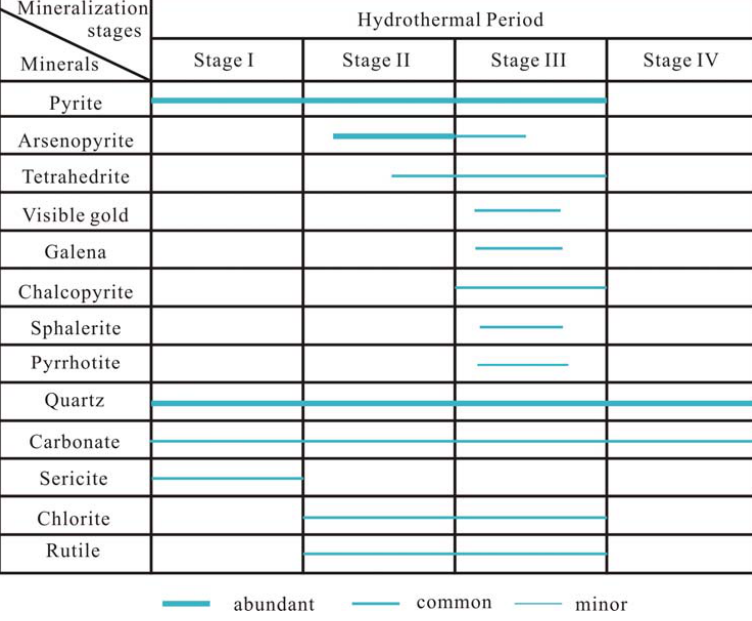
Figure 5. Paragenetic sequence of the Zhengchong gold deposit.